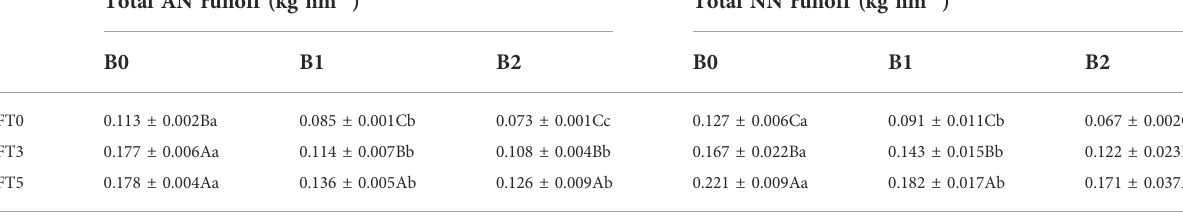
TABLE 3 Total loss of ammonia nitrogen (AN) and nitrate nitrogen (NN) under different biochar application rates. Total AN runoff (kg hm − 2